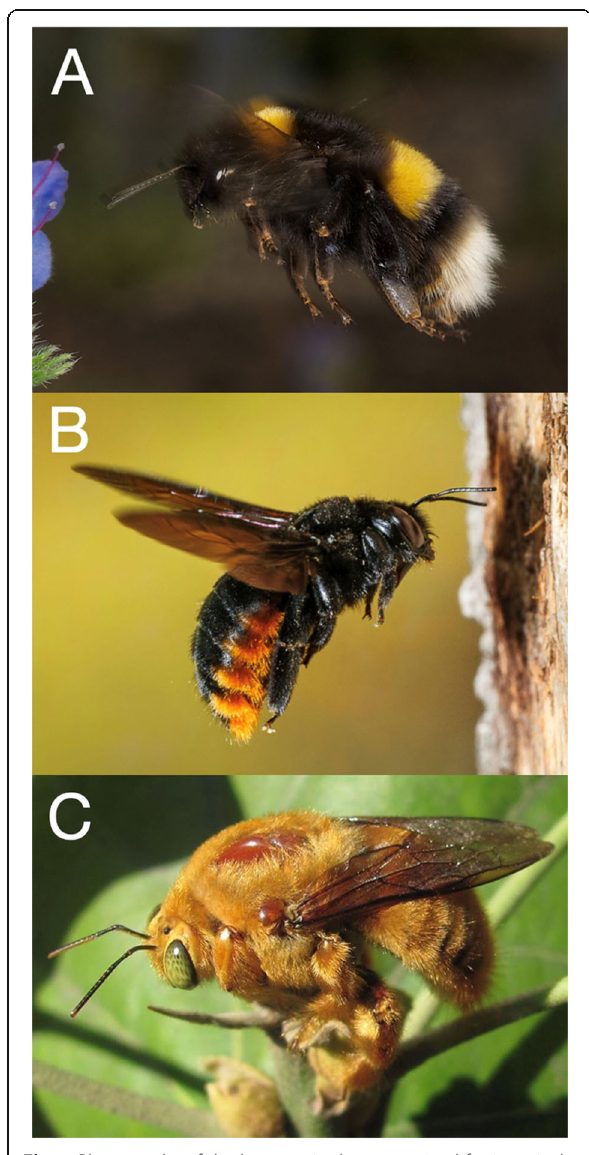
Fig. 1 Photographs of the bee species here examined for intestinal parasites. a Bombus terrestris , b Xylocopa augusti (female), c Xylocopa augusti (male) (photograph credit